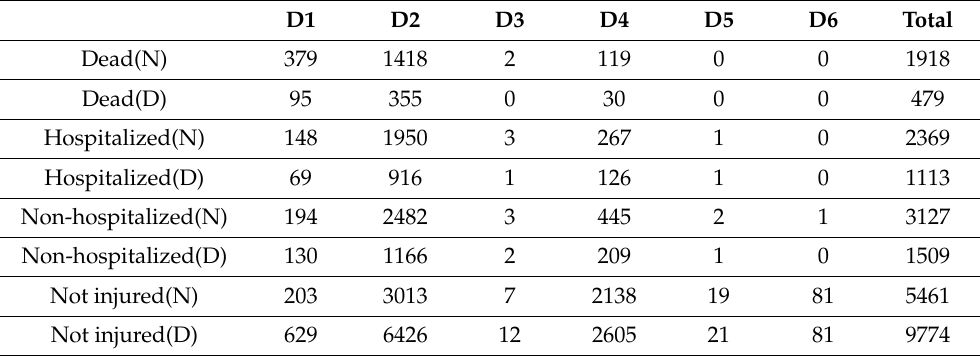
Table 17. Number of casualties in the 1721 earthquake in District 8 of